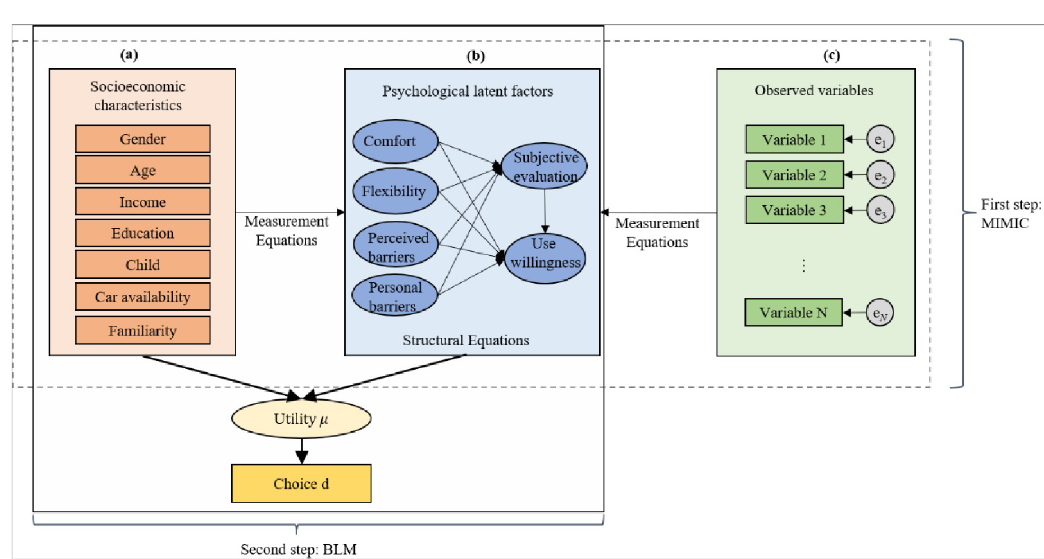
Fig 1. The framework of the integrated